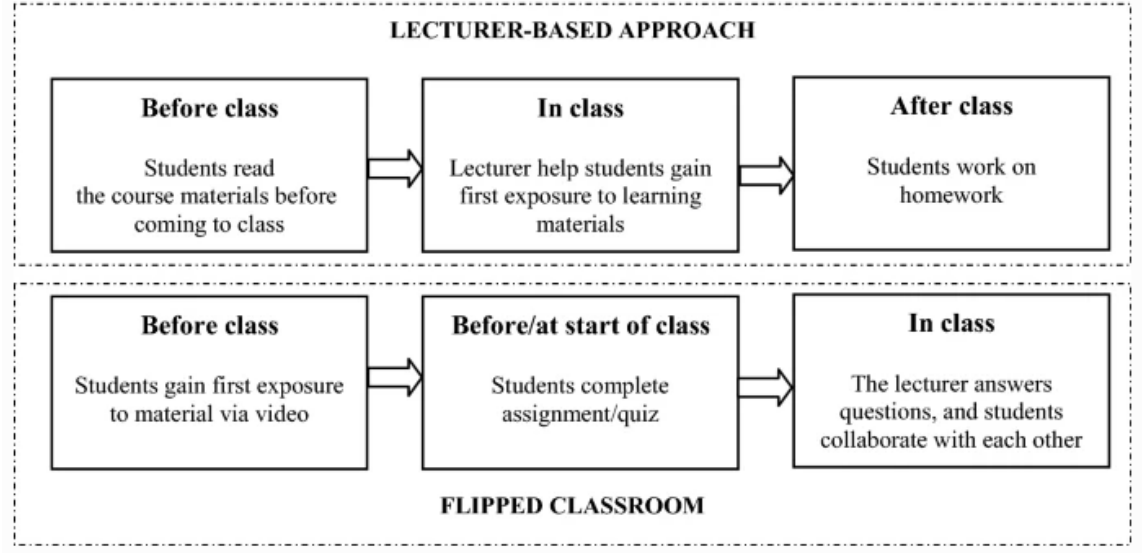
Figure 1. The lecturer-based approach vs flipped approach (Al-Samarraie et al., 2020)